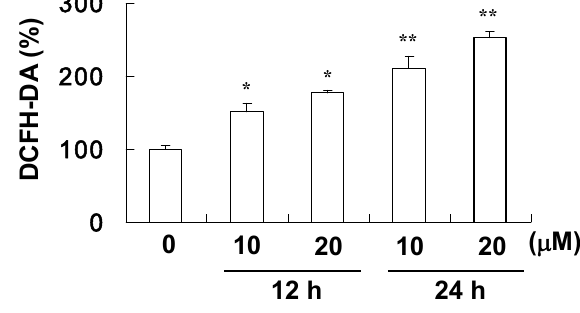
Figure 4. ROS production of A549 cells treating with davallic acid at various concentrations for 12 h and 24 h, respectively. Results are expressed as mean ± SD (n = 3). * p < 0.05 and ** p < 0.01 were compared with the first line that 0 µM